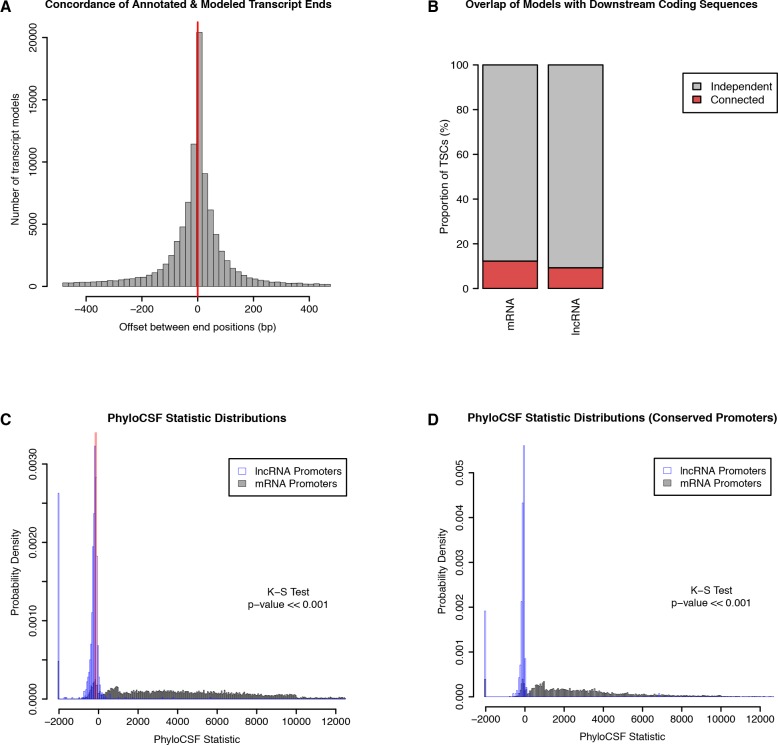
Independence and protein-coding potential of putative lncRNAs.We used published D. melanogaster embryo RNA-seq data and Cufflinks to generate transcript models, and only considered those starting within 150 bp of a TSC. (A) Concordance of annotated and Cufflinks-modeled 3’ ends. For each Cufflinks model starting at a protein-coding gene TSC, we are rep- resenting the distance to the closest annotated transcript 3’ end. (B) Fraction of TSCs for which at least one transcript model overlaps a downstream annotated CDS. Note that while a minority of lncRNA TSC transcript models overlap a downstream protein-coding genes, we observed a similar propensity of Cufflinks models to fuse together consecutive protein-coding genes. (C) PhyloCSF score distributions of protein-coding and putative lncRNA transcript models, as a measure of protein-coding potential. For each TSC, we only considered the transcript model with the highest score. Transcripts with no ORF were assigned a default score of −2000. Red lines: scores for known lncRNAs (roX1, roX2, bithoraxoid). (D) PhyloCSF analysis restricted to TSCs that are functionally conserved across all five species.